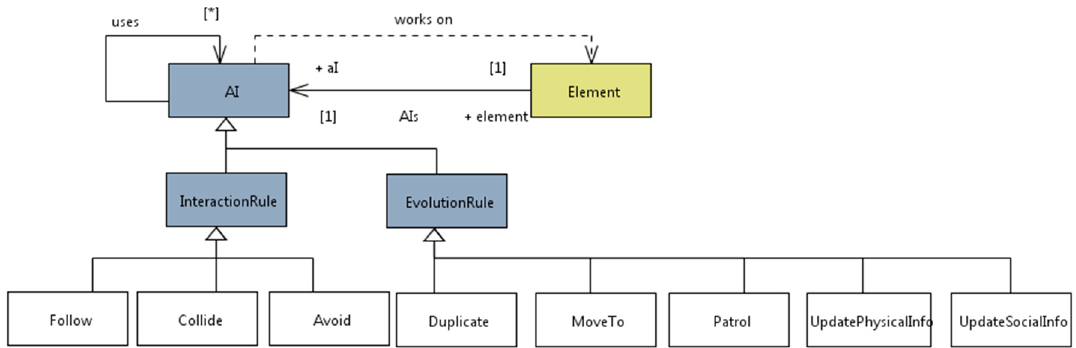
Figure 4. The pervasive game concepts in the Artificial Intelligence perspective.